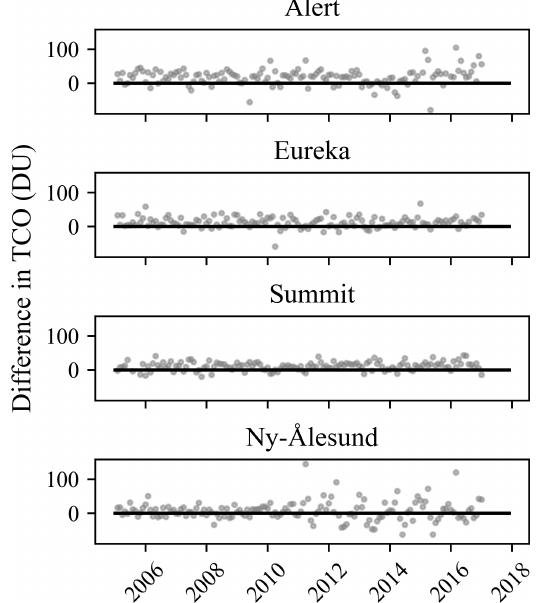
Figure 3. The difference in total column ozone (TCO) calculated using profiles from the Microwave Limb Sounder (MLS) only ver- sus profiles using ozonesonde in the lower atmosphere and MLS in the upper atmosphere. The differences are calculated as MLS only minus the ozonesonde and MLS for Alert, Eureka, Summit, and